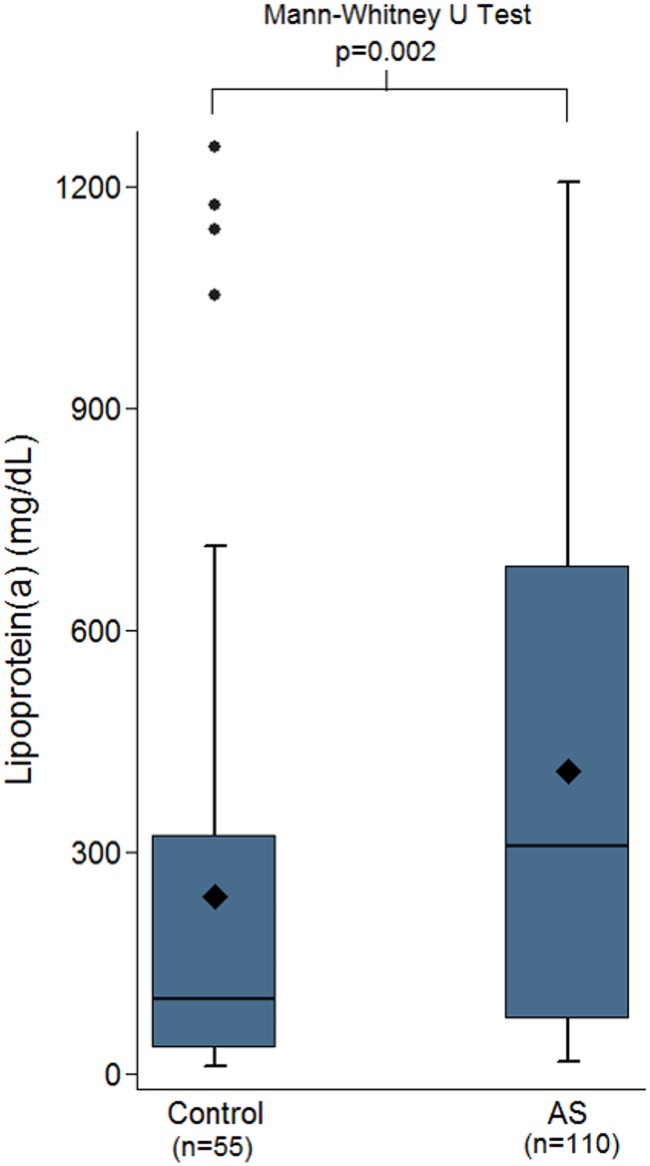
Box plots comparing controls vs. the whole cohort of aortic stenosis patients indicating that the controls had significantly lower Lp(a), median 100mg/L vs 309mg/L, p<0.001.